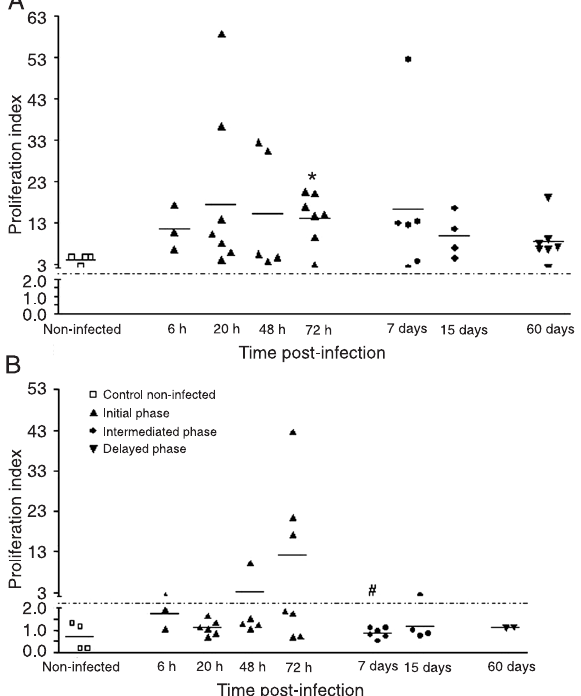
Figure 1. Proliferation of spleen cells of hamsters infected by Leishmania ( Leishmania ) chagasi . Spleen cells (2 x 10 7 cells/mL) at initial (6, 20, 48, and 72 h), intermediate (7 and 15 days) and late (60 days) time of infection were stimulated with concanavalin A (0.5 μg/mL) (A) or total antigen of LLC (5 x 10 7 parasites/mL) (B). The results are reported as proliferation index (count per min of stimulated cells/count per min of non-stimulated cells) with a cut-off (dashed line) of 2.0. *P < 0.05 vs non-infected; # P < 0.05 vs 48 h (Kruskal-Wallis test).